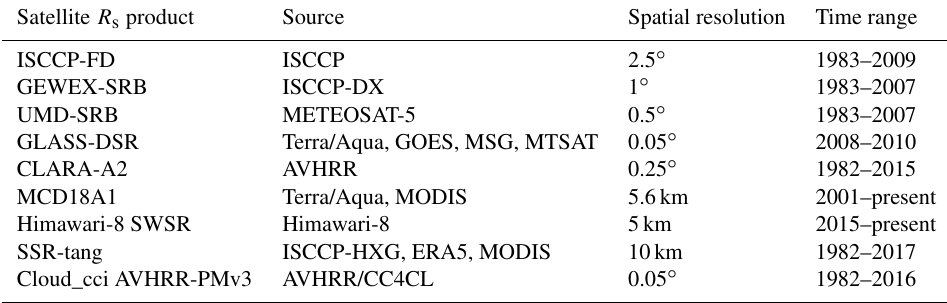
Table 1. Current satellite-derived surface solar radiation ( R s )